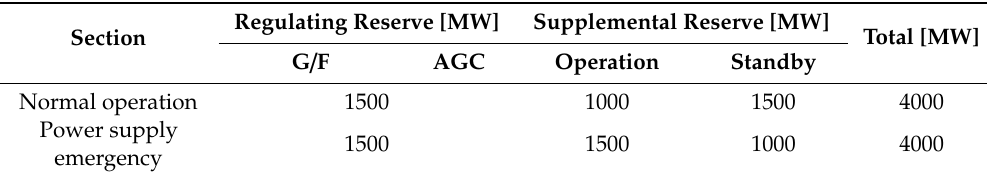
Table 1. Operating reserves in